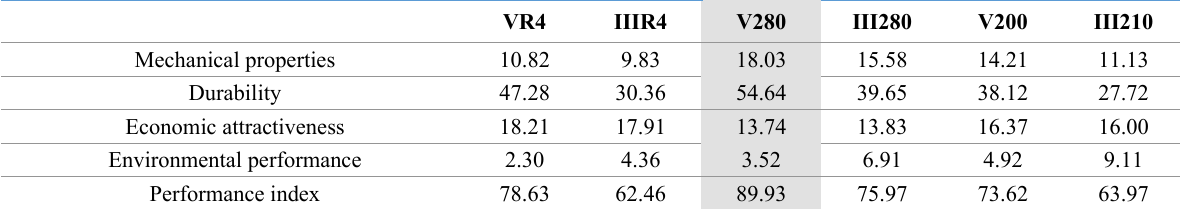
Table 10. Final Performance Index (Scenario 1 - Industrial floor).